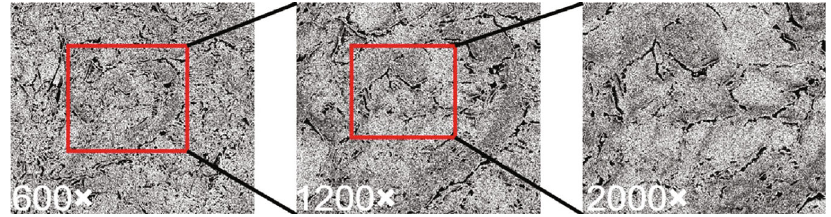
Figure 5: SEM images after